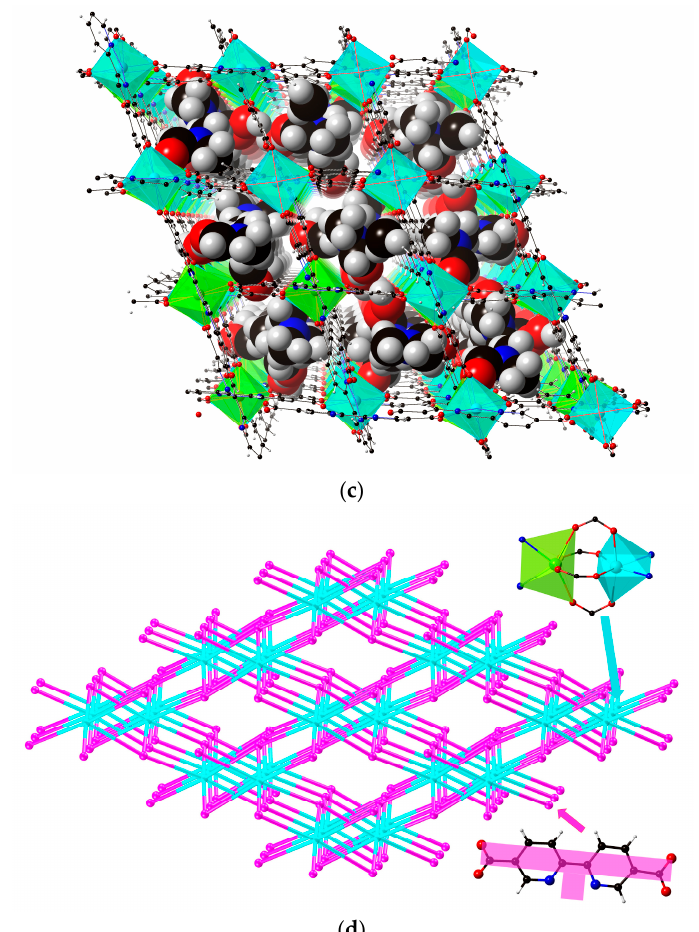
Figure 2. ( a ) Coordination environments of Cd 2+ atoms and bpdc 2 − ligand in complex 1 . ( b ) Polyhedral view (green and cyan polyhedrons represent the Cd1 and Cd2, respectively) for 3D framework composed of two infinite Cd(bpdc) plane along c-axis. ( c ) The guest molecules of DMF and H 2 O situated in the framework along the [101] direction. ( d ) The (6,3) connected topology network in complex 1 .